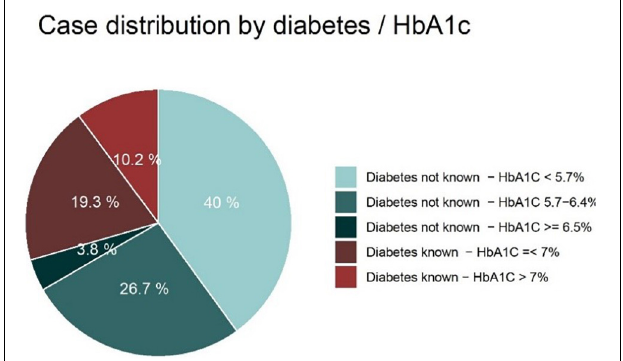
FIGURE 1 | AMI cases ( n = 2,317) by diabetes status and HbA1c